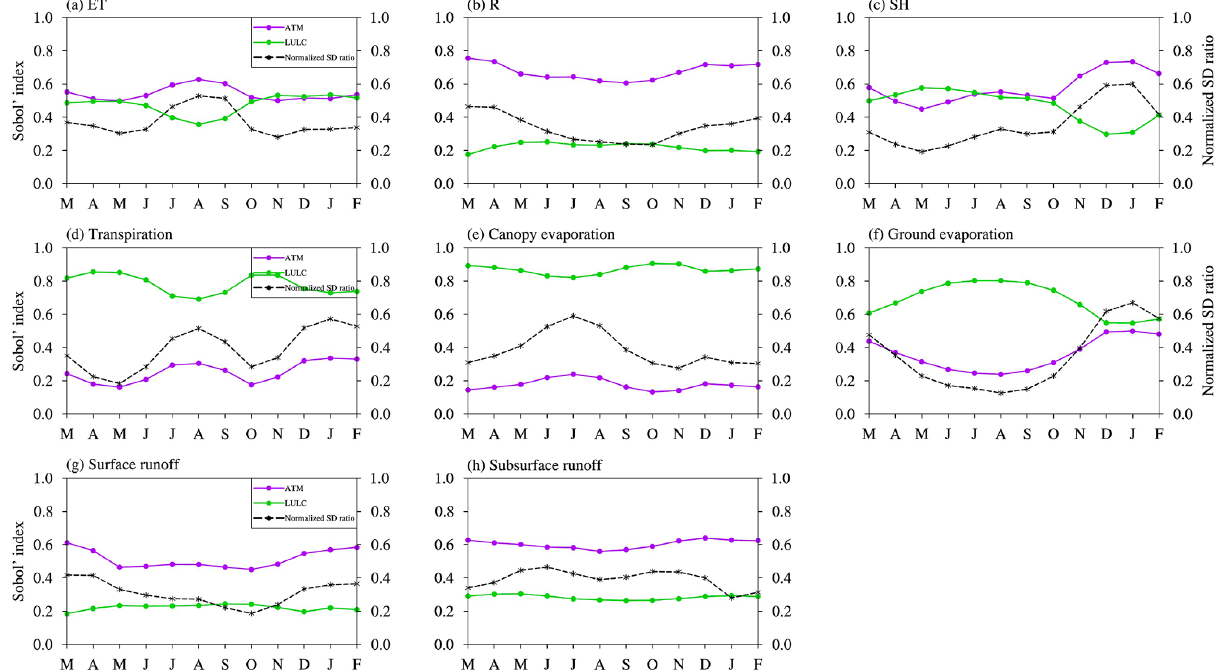
Figure C1. Monthly variations of CONUS-averaged ATM and LULC Sobol’ total sensitivity index to ATM and normalized SD ratio for (a) ET, (b) R , and (c) SH, (d) transpiration, (e) canopy evaporation, (f) ground evaporation, (g) surface runoff, and (h) subsurface runoff,